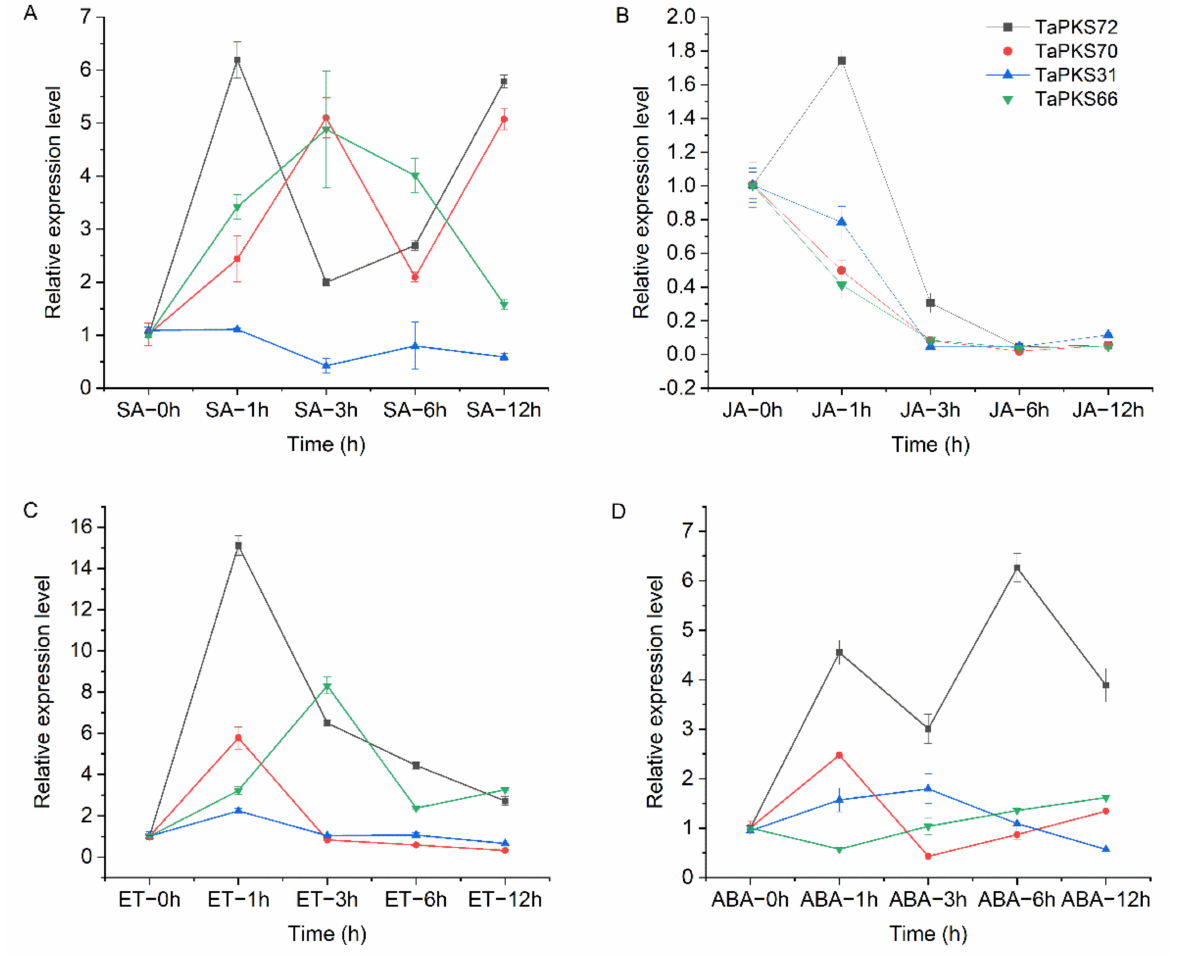
Figure 11. Expression patterns of four TaPKS genes in resistant materials after treatment with salicylic acid (SA), methyl jasmonate (MeJA), ethylene (ET), and abscisic acid (ABA). A – D represent the expression trend of four TaPKS genes treated with salicylic acid, jasmonic acid, ethylene and abscisic acid respectively. The average expression values were calculated based on three independent replicates. Error bars represent standard